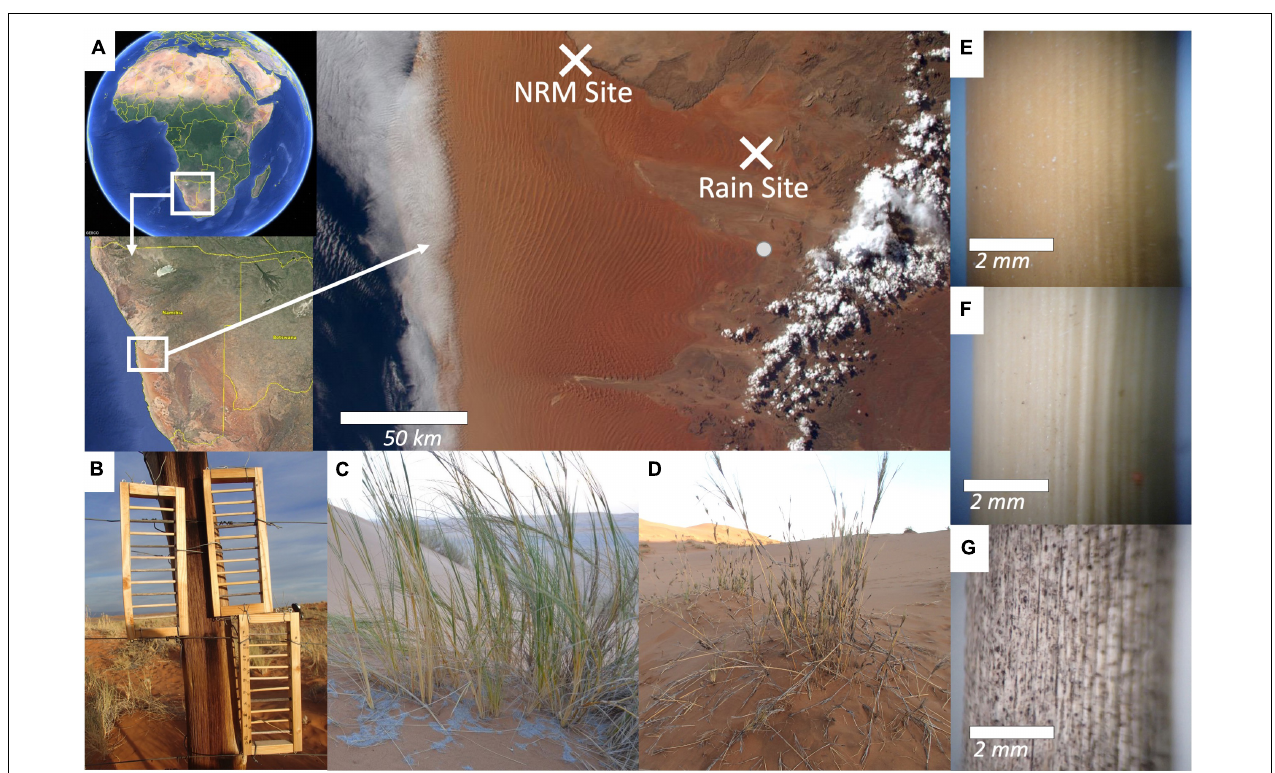
FIGURE 1 | (A) Location of field sites in the Namib Sand Sea, with visible coastal fog in the west and rain clouds in the east (https://twitter.com/astroterry/status/ 590929048596951040), the gray dot shows the location of the Dieprivier weather station that served as a proxy weather station for the Rain Site for two months; (B) litter racks to minimize microclimate effects and ensure that tillers were fully exposed to sunlight and ambient moisture conditions at both locations; (C) living S. sabulicola hummock in the dunes; (D) standing dead S. sabulicola tillers will persist for years; (E–G) as tillers decompose, the outer cuticle is degraded and dark pigmented fungi colonize the